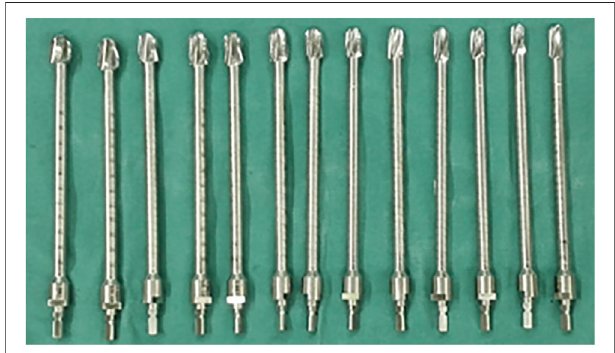
FIGURE 2 | The fl exible reamers of different diameters that we used in this